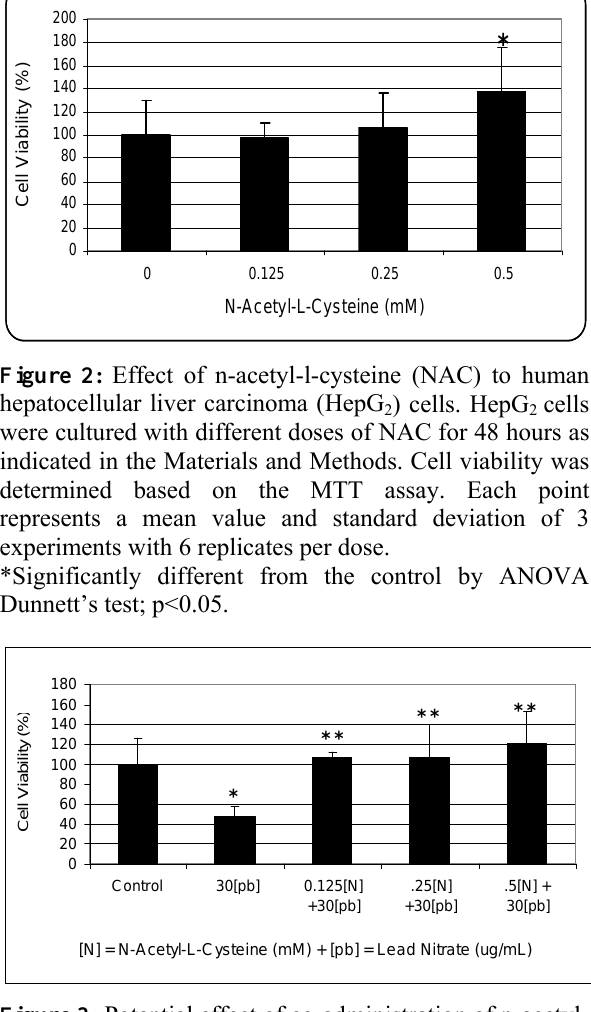
Figure 3: Potential effect of co-administration of n-acetyl- l-cysteine (NAC) and lead nitrate to human hepatocellular liver carcinoma HepG cells. HepG cells were cultured in 2 2 the absence or presence of NAC and lead nitrate or in combination of NAC and lead nitrate for 48 hr as indicated in the Materials and Methods. Cell viability was determined based on the MTT assay. Each point represents a mean value and standard deviation of 3 experiments with 6 replicates per dose. *Significantly different from the control by ANOVA Dunnett’s test; p < 0.05. **Significantly different from lead nitrate by ANOVA Dunnett’s test; p <